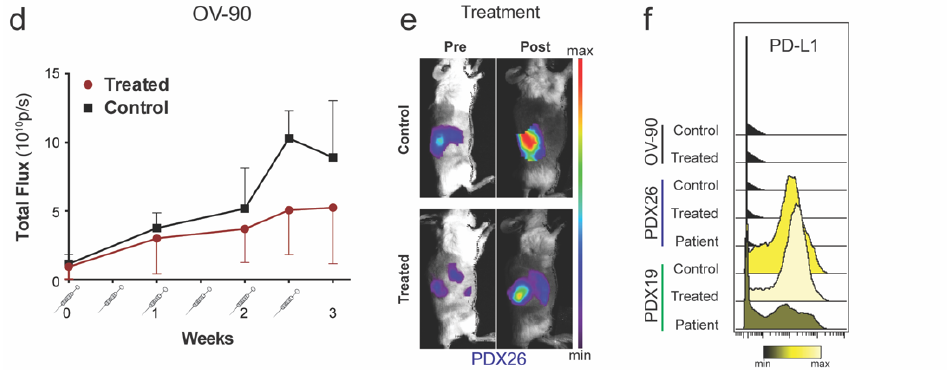
Figure 5. Effect of Nivolumab on tumor growth and prolonged disease latency for an orthotopic OV-90 luc+ cell line model and two patient-derived xenograft models. ( a ) Experimental design for anti-PD-1 nivolumab treatment with a schematic of expected tumor growth and developing T cells over time. Treatment started 12 weeks after intravenous injection of 1 × 10 5 CD34 + cells in both CDX and PDX NSG models. Mice ( n = 18) were allocated to treatment and control arms at week 11 according to bioluminescence signal intensity, chimerism level (blood sample week 11) and frequency of T cells (blood sample week 11). The treatment group received 2 mg/kg nivolumab intraperitoneally twice a week for two consecutive weeks and 100 mg/kg twice in the third week of treatment. Blood samples were collected in week 8 to confirm the successful immune reconstitution, in week 11 to allocate the mice into control and treatment groups, and week 15 to assess the effect of treatment. The 11-week samples additionally served as reference pretreatment samples for mass cytometry analysis. ( b ) Frequency of human leukocytes and T cells in mouse blood measured by flow cytometry in weeks 8, 11 and 15 after treatment (weeks from CD34 + cell injection). Human leukocytes are shown for all mice ( n = 18) and CD3 positive cells are presented separately for treated (dashed lines, n = 9) and untreated (solid lines, n = 9) mice. ( c ) Survival of OV-90 luc+ ( n = 10), PDX19 ( n = 4), and PDX26 ( n = 4) mice measured as days after the start of tumor engraftment. ( d ) Bioluminescence imaging of OV-90 luc+ mice was performed to monitor tumor growth during treatment ( n = 5/group). ( e ) One representative fluorescence image of patient-derived xenografts (PDX26) in control and treated mice pre- and post-treatment. ( f ) Histograms of PD-L1 expression on tumor cells (black = minimum, yellow = maximum median dual count) by mass